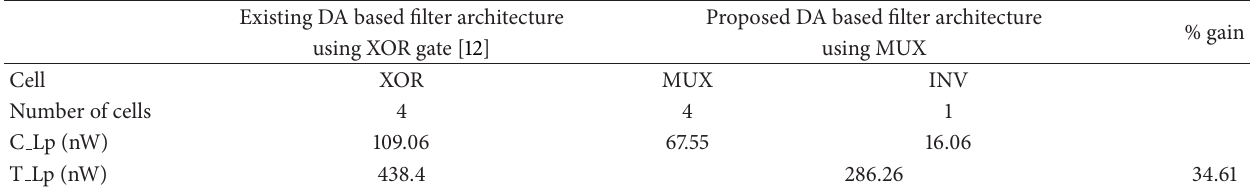
Table 1: Leakage power of the existing and proposed logics of input pattern generator.